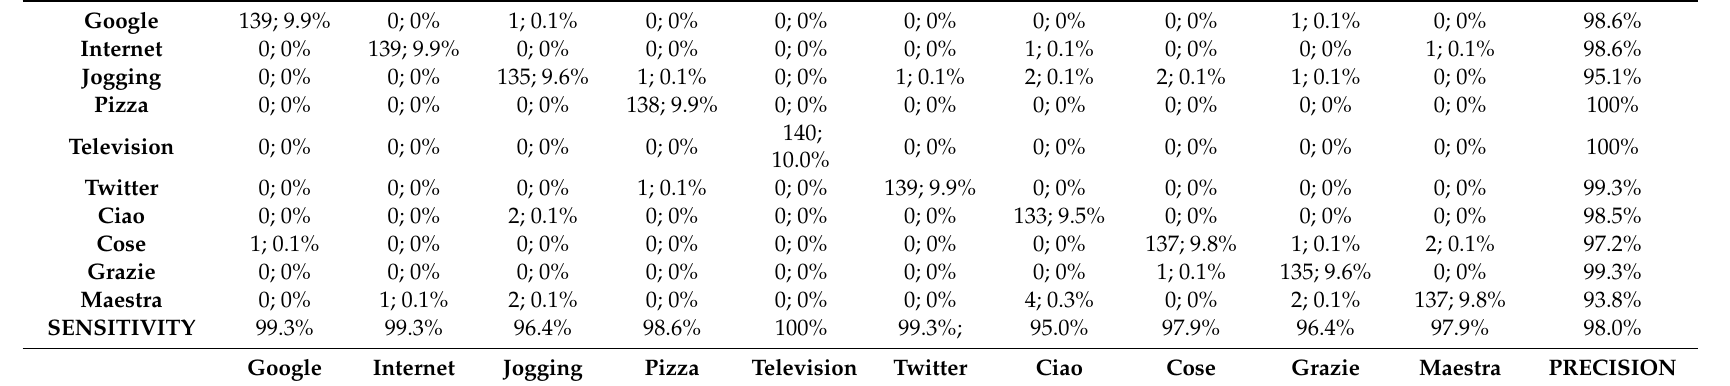
Table 2. Confusion matrix for the CNN classification